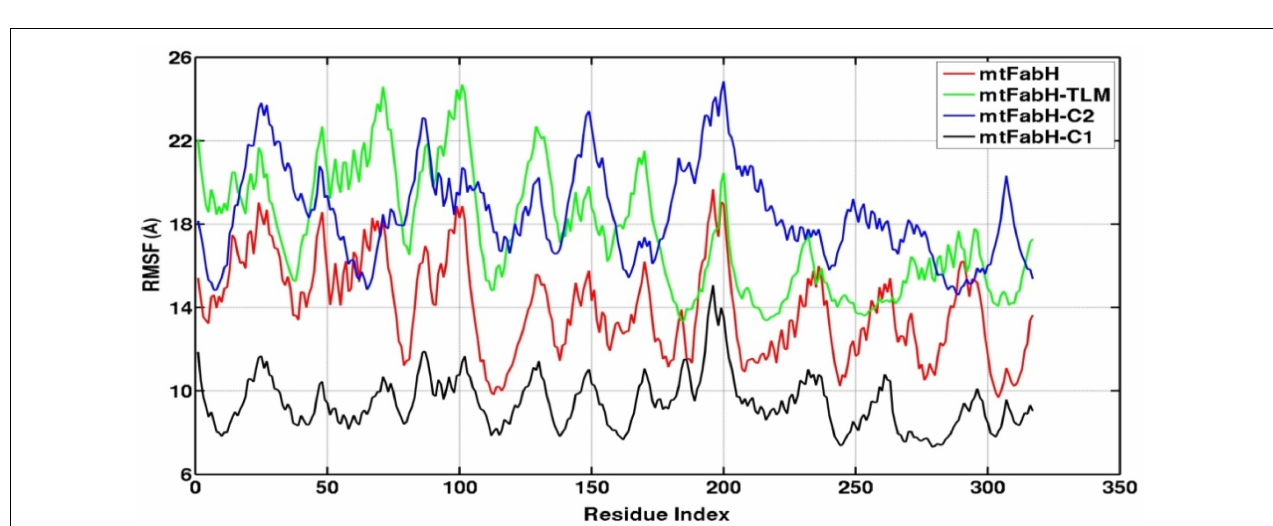
FIGURE 9 | Radius of gyration (Rg) plots of mtFabH and complexed with TLM and lead molecules, C1 and C2.